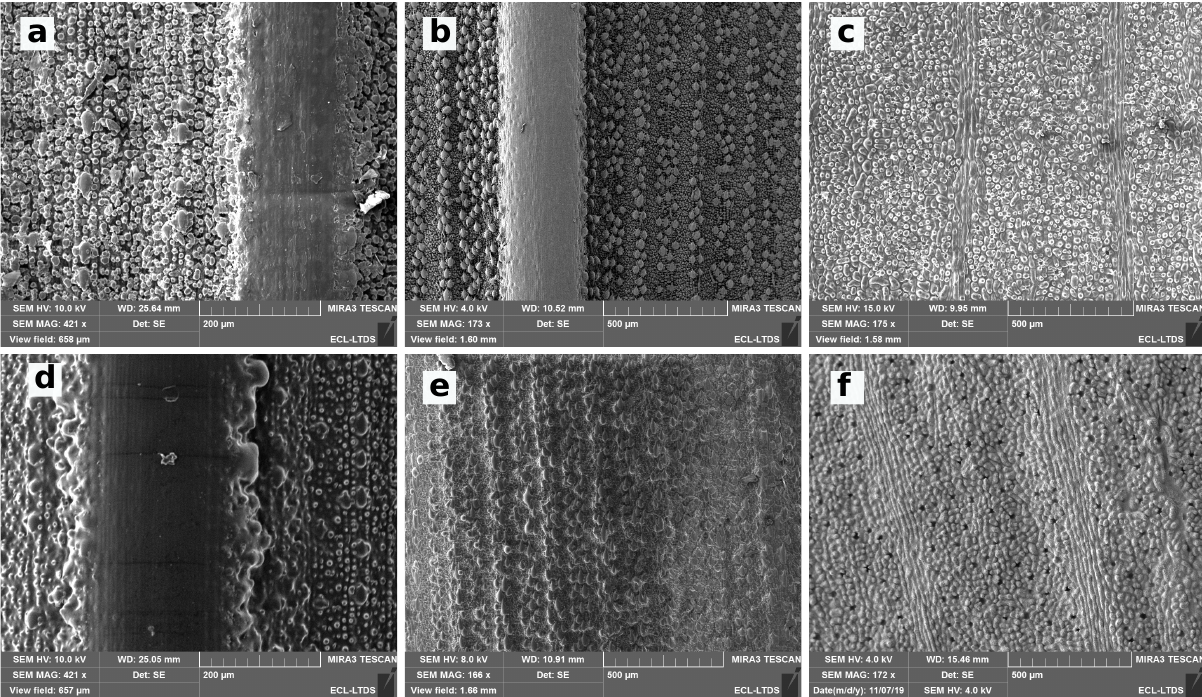
Figure 7. SEM images of ( a ) Phyllostachys, ( b ) Sasa, and ( c ) Ginkgo Biloba leaves and ( d – f ) their respective PDMS replica. Leaves and replicas are also compared by interferometric measurements (Figure